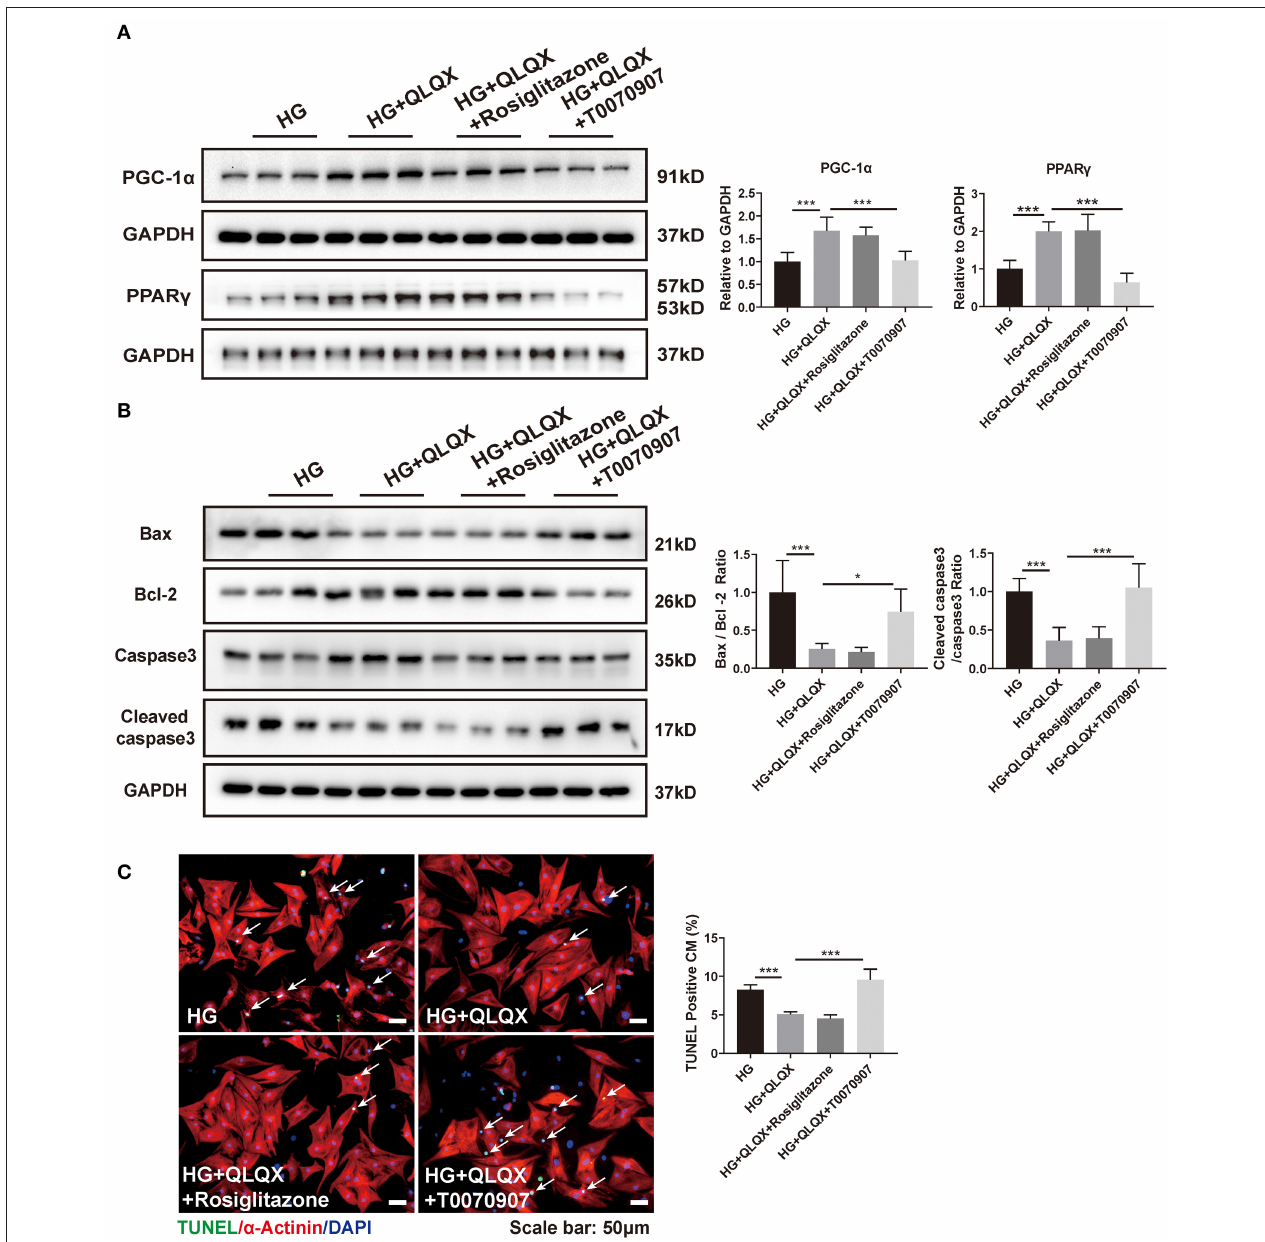
FIGURE 3 | QLQX prevents hyperglycemia-induced apoptosis via activating PPAR γ in NRCMs. (A) Effect of a PPAR γ agonist (rosiglitazone) or inhibitor (T0070907) on QLQX-induced activation of PPAR γ and PGC-1 α ( n = 6). (B,C) Western blot analysis and TUNEL assay displayed that the PPAR γ inhibitor abrogated